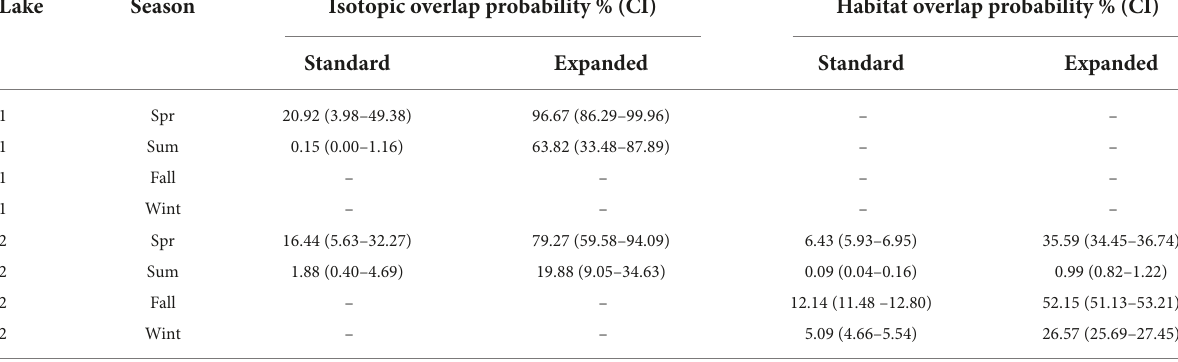
TABLE 2 Probability and credible interval (CI) of isotopic and habitat niche overlap between lake trout and smallmouth bass, calculated using nicheROVER (R package; Swanson et al.,